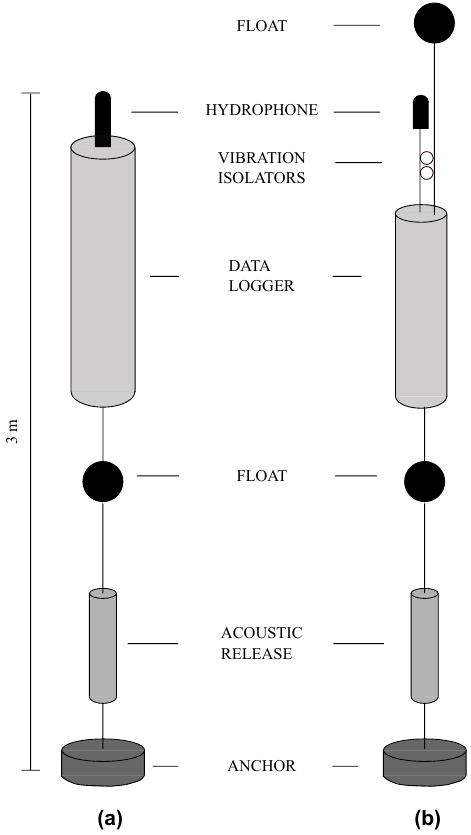
Figure 2. Mooring setups for ( a ) SM2M and ( b ) ST500 data